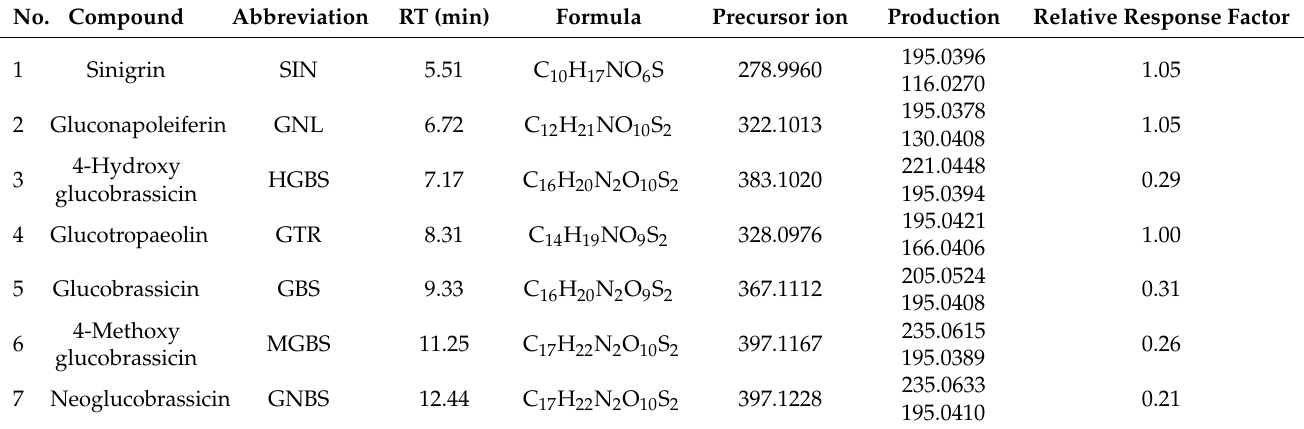
Table 1. Desulfo glucosinolates determined through ultra-high performance-quadrupole time of flight mass spectrometry (UPLC